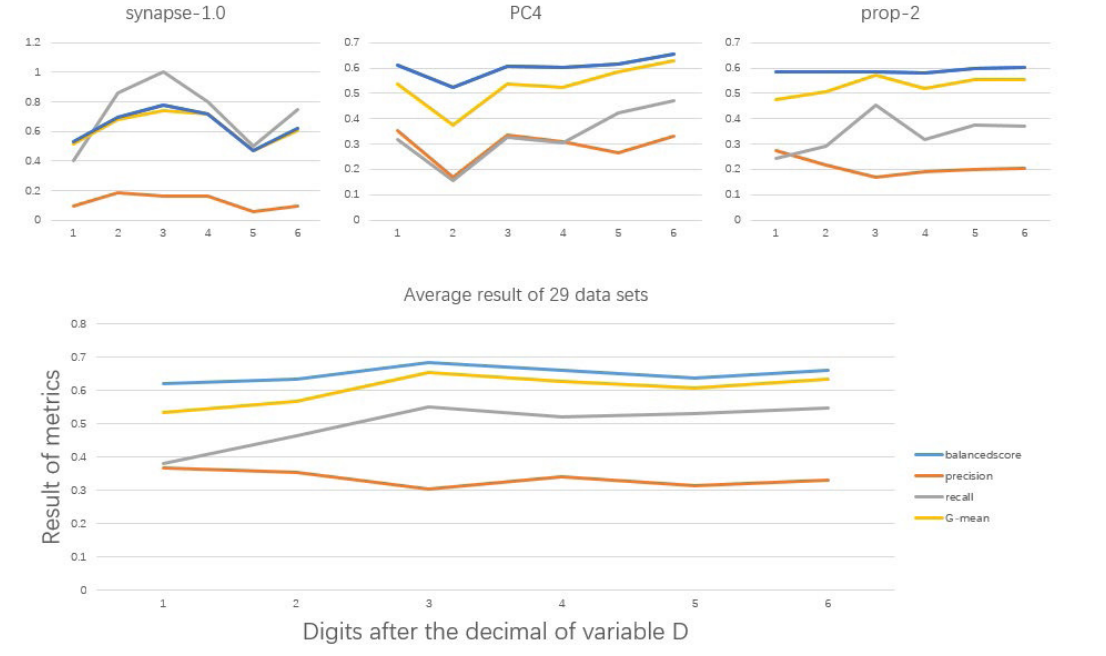
Figure 6. Result of LIMCR with different precision of variable D